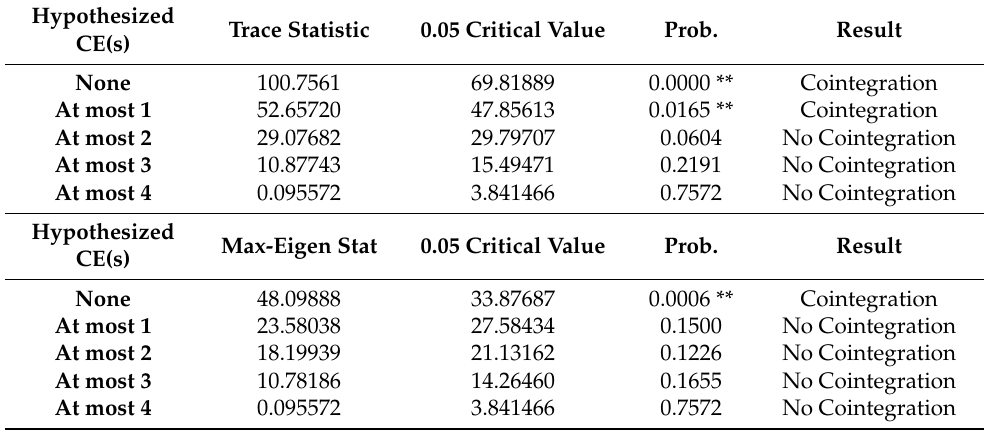
Table 6. JJ model for off-season